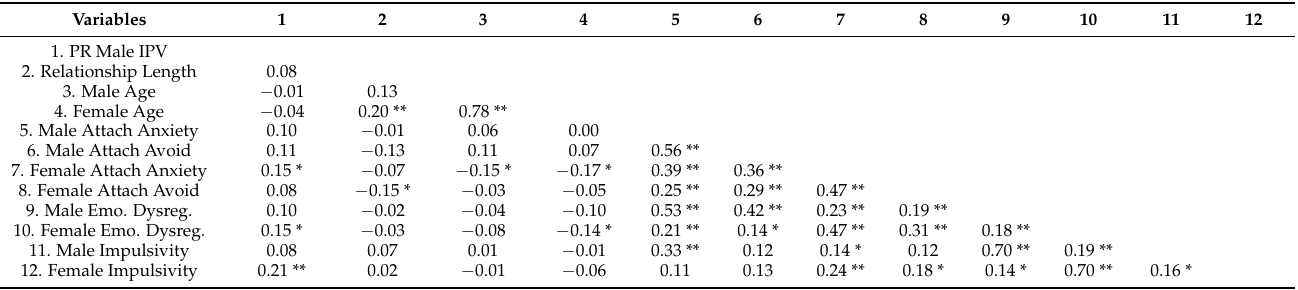
Table 3. Bivariate correlations among partner-reported male IPV, relationship length, age, attachment, emotion dysregula- tion, and impulsivity.